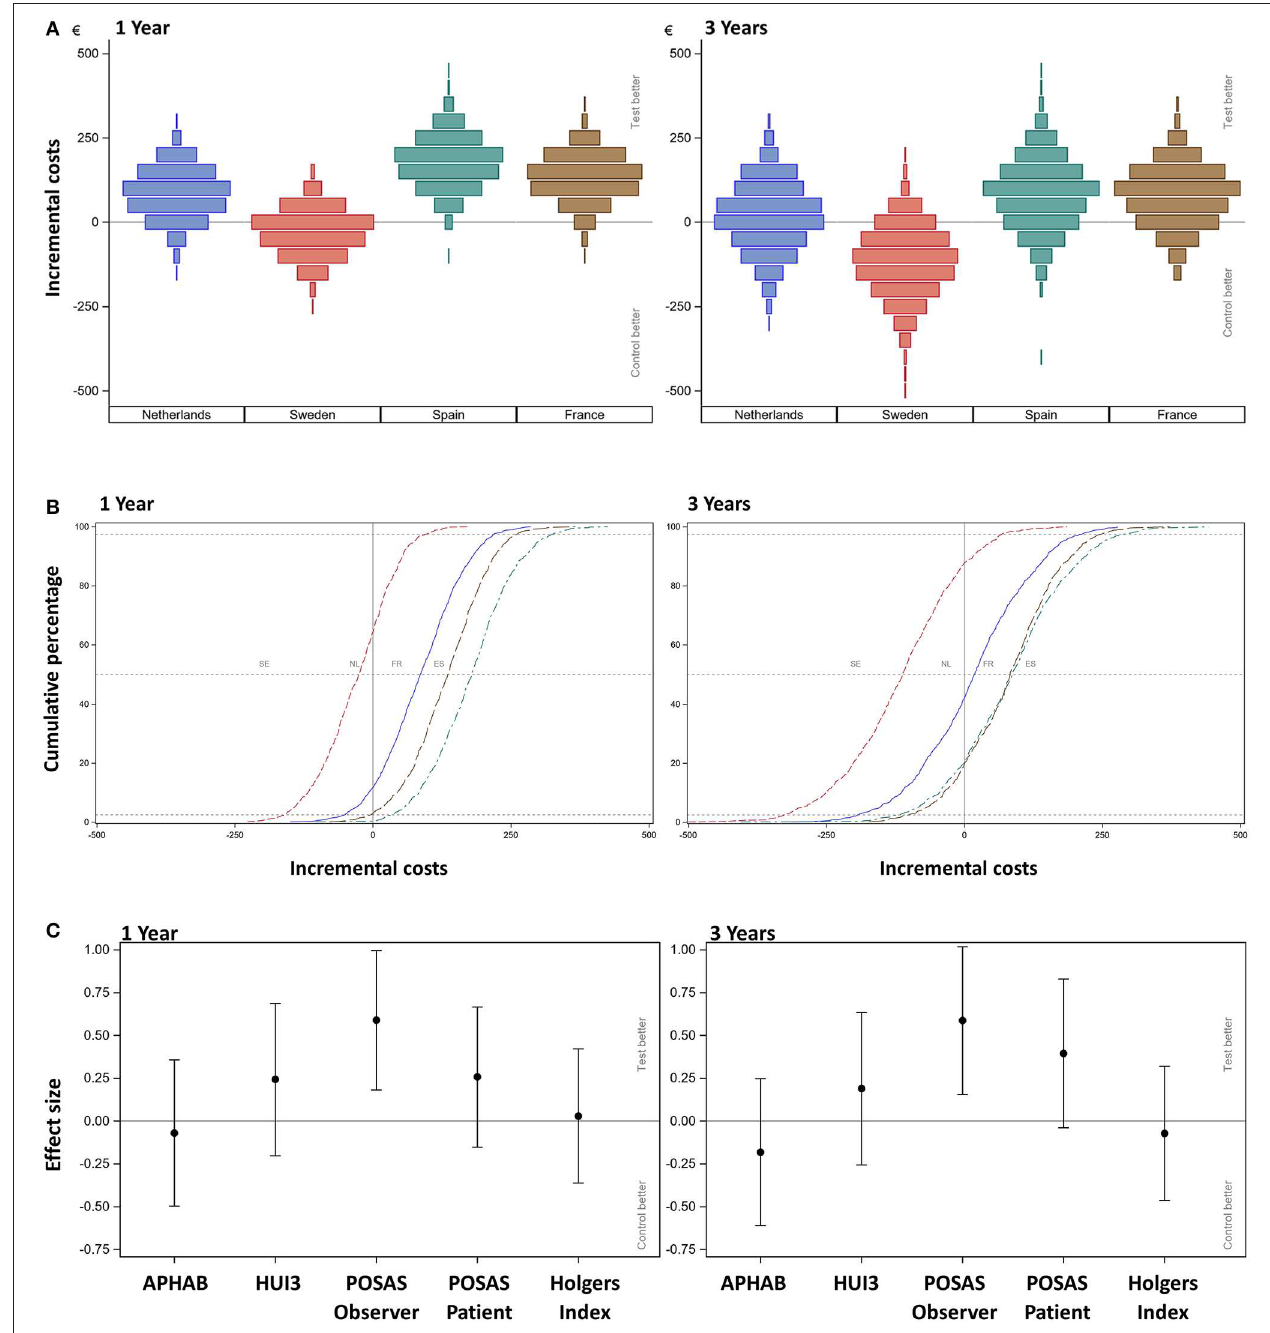
FIGURE 3 | (A) Scenario analysis—cost-consequence analysis after 1 and 3 years. The incremental mean cost per subject, per country as simulated using 1,000 bootstraps using unrestricted random sampling which was displayed using a density histogram. A positive number indicates a cost saving in favor for the test intervention. For this simulation all subjects were all allocated one-by-one to every of the participating countries per simulation . (B) Scenario analysis after 1 and 3 years. The cumulative probability distribution of incremental costs per country. A positive number indicates a cost saving in favor for the test intervention. The country is indicated per line; notice that the sequence of countries differs from the other figures as the order relates to the increment between the test and control intervention. Dashed lines indicate the 2.5, 50, and 97.5%. (C) Cost-consequence analysis after 1 and 3 years. The effect sizes for the different outcome measures (AUCs) over the first year together with the 95% confidence interval are displayed. Note that the APHAB and HUI3 were calculated as the change from (the unaided) baseline.